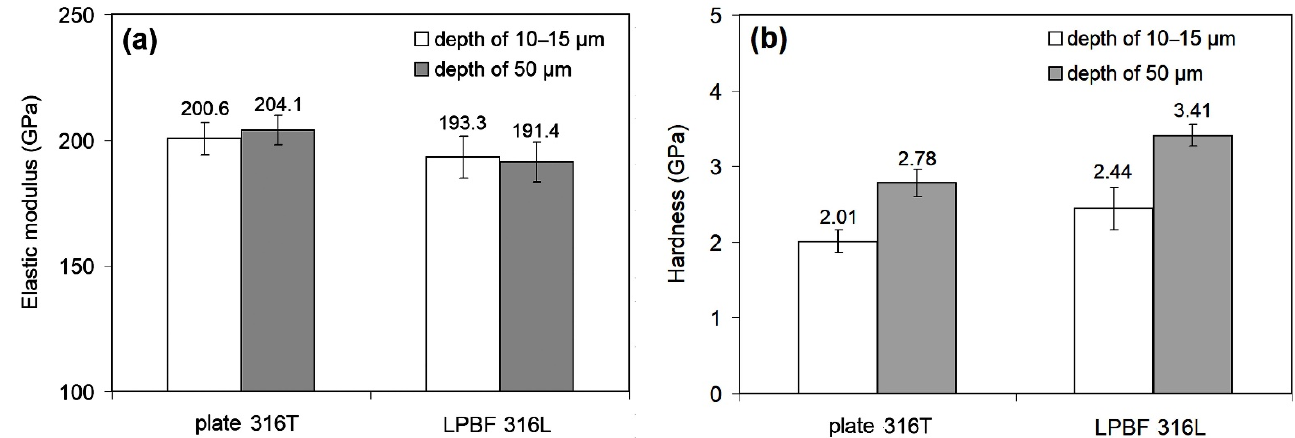
Figure 9. XRD patterns of pulsed-plasma-treated specimens.